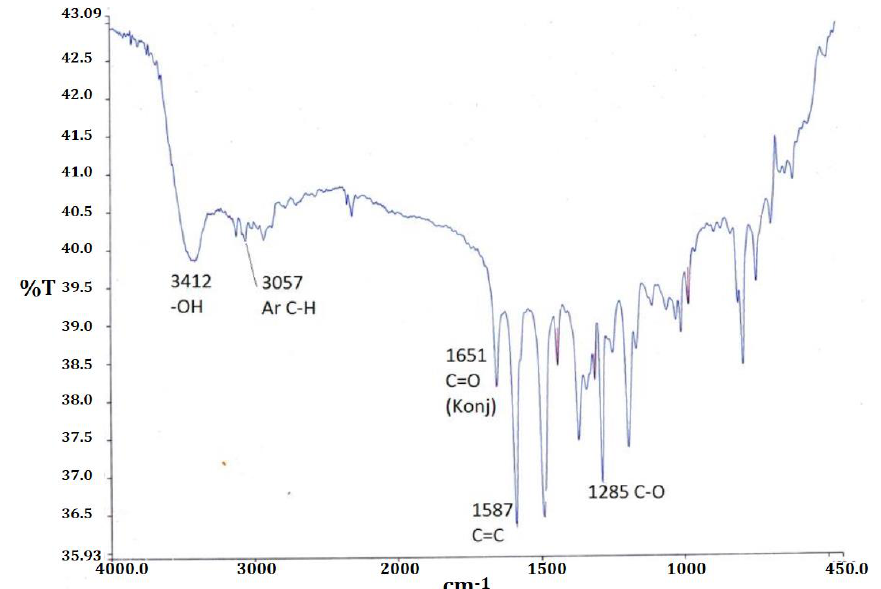
Figure 7. The structure of 1- (2,5-dihydroxyphenyl) - (3-pyridine-2-il) –propenone compounds having two systems of benzoyl chromophore and 3-pyridine-2-il-acrylyl